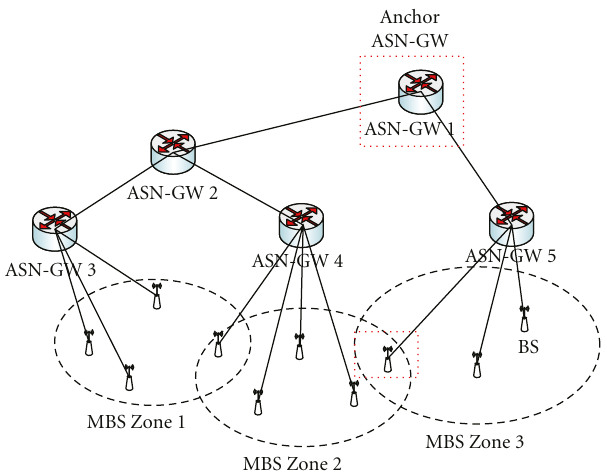
Figure 1: MBS Zones and their associated Anchor